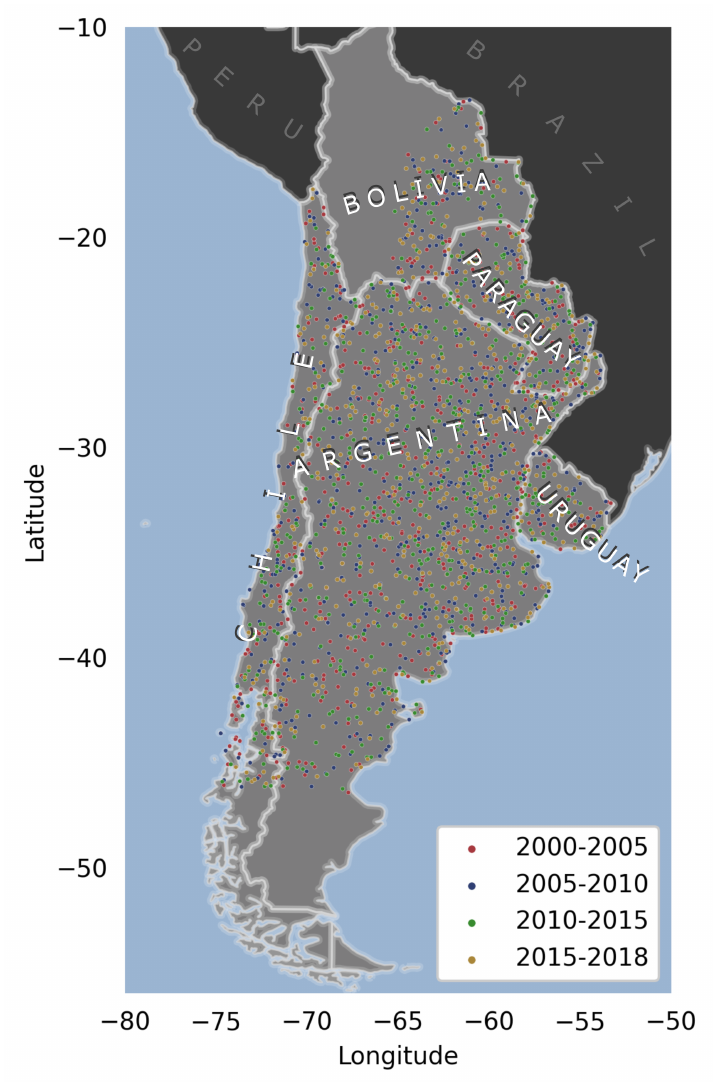
Figure 5. Reference points collected for four time periods assessed in this